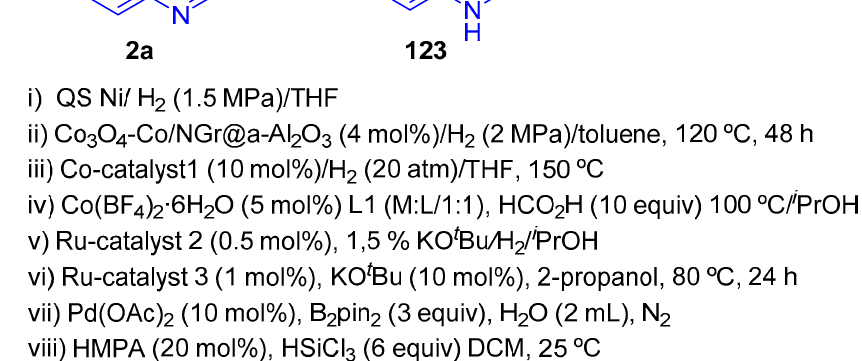
Figure 4. Catalyst and ligand structures. In the presence of KO t Bu, N -heterocyclic carbene-supported half-sandwich complex [Cp(IPr)Ru(pyr)2]-[PF6] ( Catalyst 2 , Figure 4) catalyzes transfer hydrogenation of N -heterocycles in isopropanol at the catalyst loading of 0.5 mol%. Under these conditions, 1,5-naphthyridine 2a (previously prepared, vide supra, Scheme 1) could be hydrogenated in good yields (v, Scheme 47; Figure 4) [80]. In another approach, the transfer hydrogenation of 1,5-naphthyridines could be accomplished in good yields, using ruthenium(II) complexes ( Catalyst 3 ) supported by a pyrazole- phosphine ligand (vi, Scheme 47, Figure 4) [81]. A Pd-catalyzed transfer hydrogenation of various N -heteroaromatic compounds with bis (pinacolato)diboron (B2pin2), as a mediator in environmentally benign water as both solvent and hydrogen donor has been disclosed. This reaction proceeded under ambient temperature and 1,5- naphthyridine 2a (previously prepared, vide supra, Scheme 1) underwent selective hydrogenation in one of the pyridine rings (vii, Scheme 47) [82]. A method for the hexamethylphosphoric triamide (HMPA)-catalyzed metal-free transfer hydrogenation of pyridines by using trichlorosilane hydride (HSiCl 3 ) has been developed. The suitability of this method for the reduction of other N -heteroarenes has also been demonstrated. Thirty-three different substrates have been reduced to designed products in 45–96% yields. 1,5-